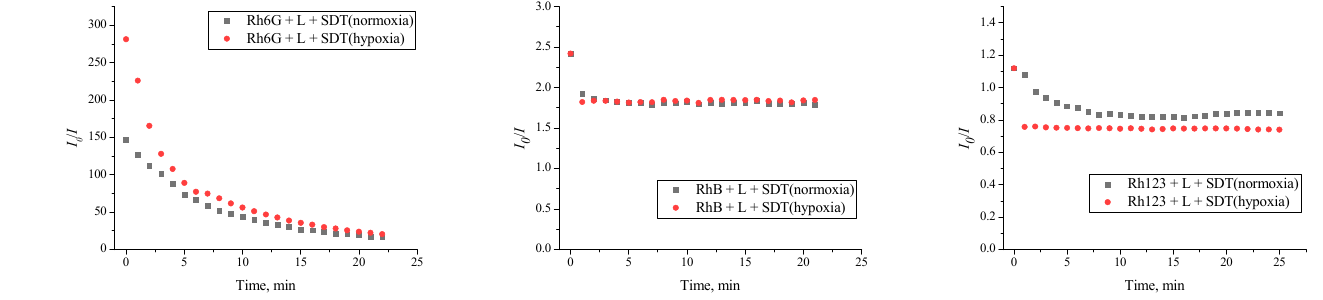
Figure 7. Fluorescent responses of Rh6G - L (30/10 μ M) at 545 nm ( λ ex = 490 nm) to various reduct- ants. The complex was treated with either SDT or various biological reductants (Cys: Cysteine, GSH: glutathione, NADPH: reduced nicotinamide adenine dinucleotide phosphate) under normoxic or hypoxic conditions. Incubation time is 25 min. C ( Rh6G ) = 10 μ M, C ( L ) = 30 μ M, C (reductants) = 100 μ M, PBS buffer (pH 7.4) at 37 °C. 3. Materials and Methods 3.1. Sample Preparation The phosphate-buffered saline (PBS) solution with pH 7.4 was prepared by dissolv- ing powder (Sigma P-3813) in 1000 mL of Milli-Q water. The stock solutions (100 μ M) of macrocycles and dyes were prepared by dissolving the corresponding chemicals in PBS buffer. The fluorescence titrations were performed by successive addition of known